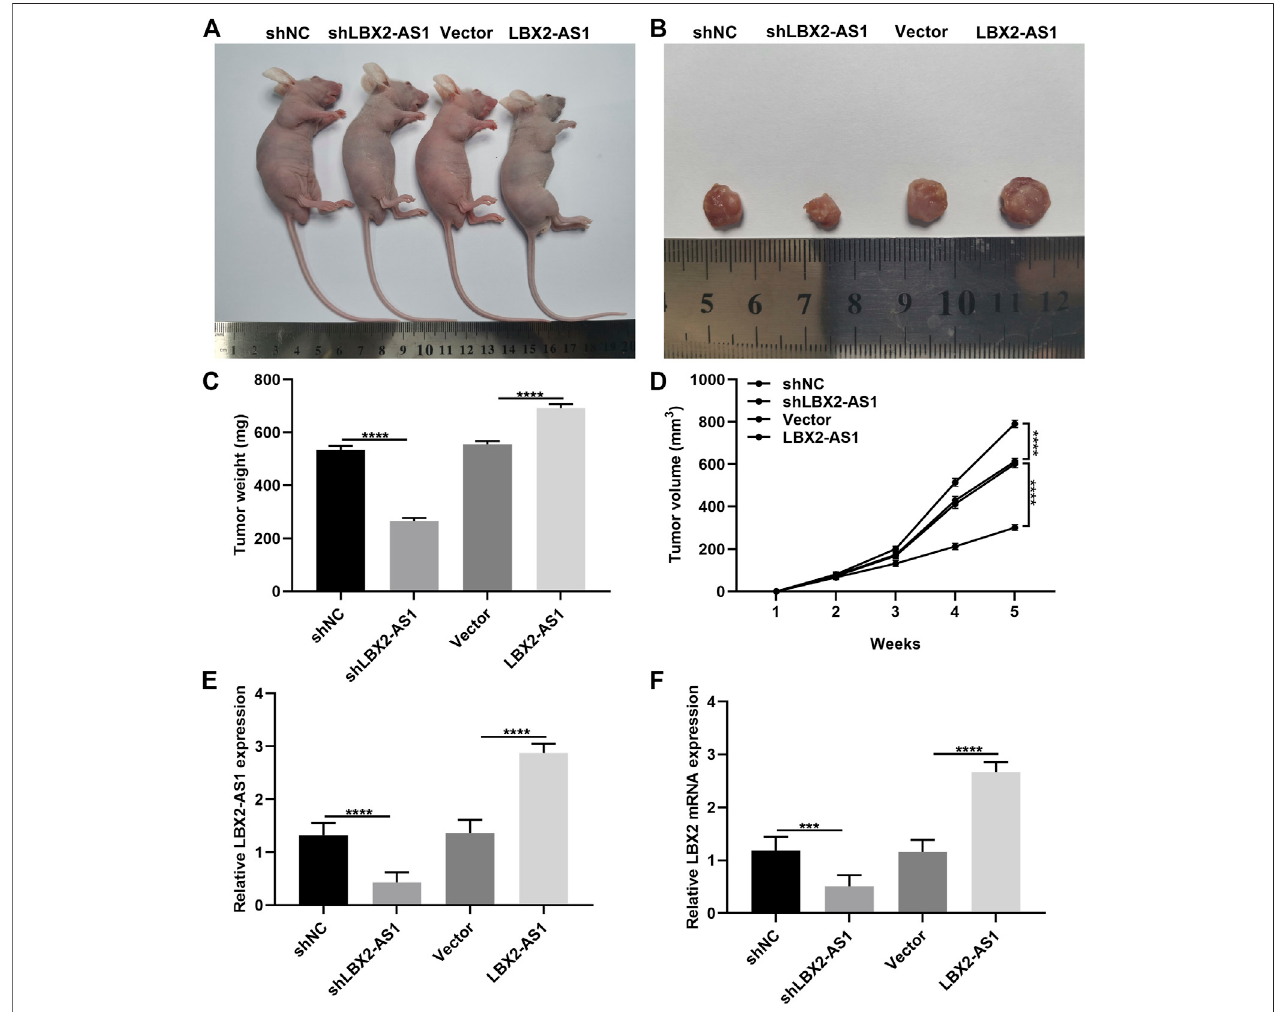
FIGURE8| SilencingLBX2-AS1 suppressestumor growthofMM. (A) RepresentativeimagesofnudemicetreatedwithNCI-H929cellsthatweretransfected with shNC, shLBX2-AS1, empty vector and LBX2-AS1 overexpression. (B) Representative images of tumors from above nude mice after 5 weeks. (C) Detection of tumor weightaftertreatmentfor5 weeks. (D) Detectionoftumorvolumeineachweek. (E,F) RT-qPCRexaminingtheexpressionofLBX2-AS1andLBX2intumortissuesfrom above nude mice after treatment for 5 weeks. *** p < 0.001; **** p < 0.0001.